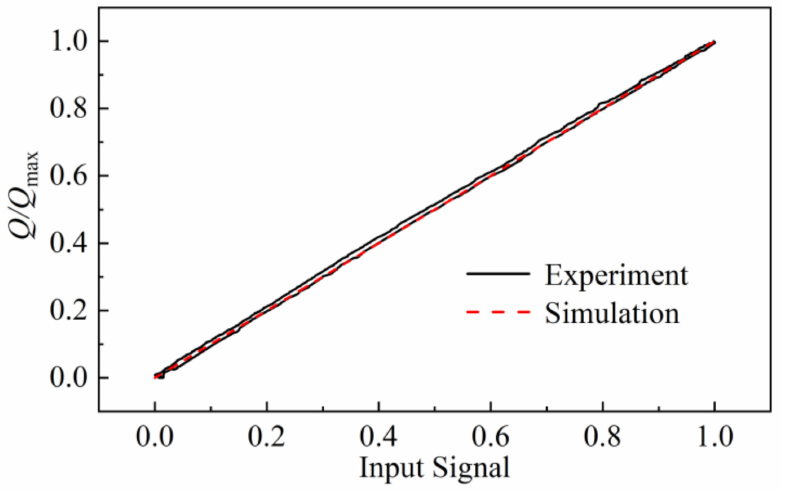
Figure 17. Static flow characteristic